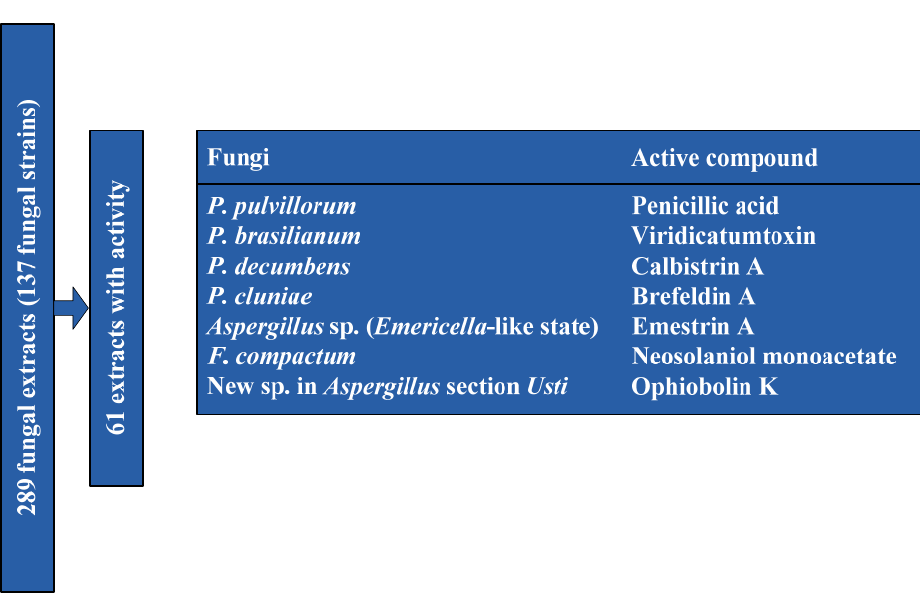
Figure 2. Dereplication of penicillic acid from P. pulvillorum mass spectrum of penicillic acid [23]. The mass spectrum shows a widespread adduct pattern that besides [M+H] + contains ions that corresponds to neutral loss of water [M+H-H adduct [M+Na] + , as well as the corresponding dimeric ions [2M+H] + , [2M+H-H and [2M+Na] +